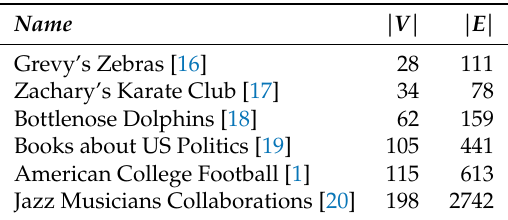
Table 1. The social networks used in the